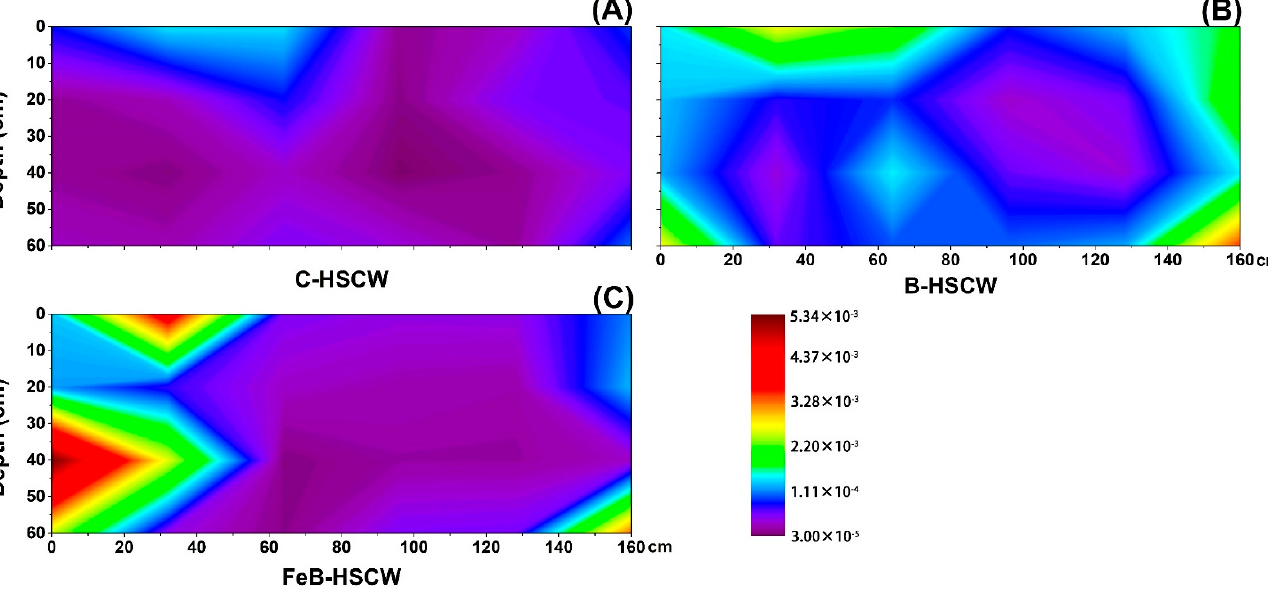
Figure 5. The spatial distribution of napA relative abundance in C-HSCW ( A ), B-HSCW ( B ), and FeB-HSCW ( C ) based on interpolated maps. Color scales indicate extrapolated values by kriging. C-HSCW, without biochar and FeB-modified biochar; B-HSCW, with biochar; FeB-HSCW, with FeB-modified biochar.